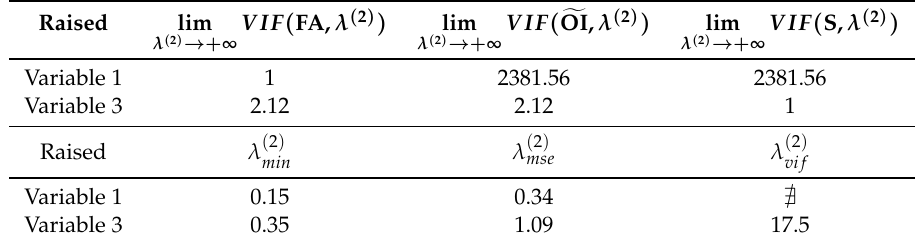
( 2 ) ( 2 ) , λ mse , and λ min